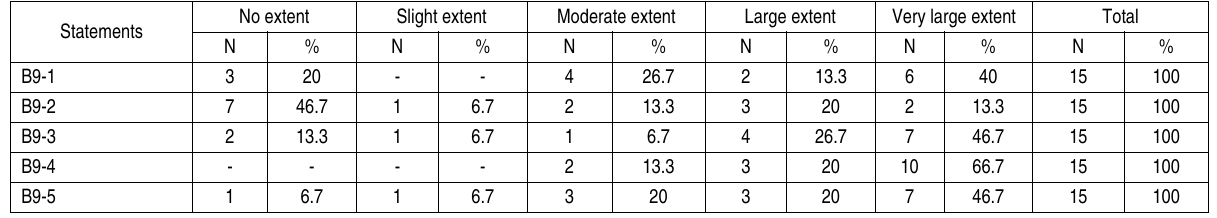
Table 12. Perceptions of the respondents on the statement relating to supply chain